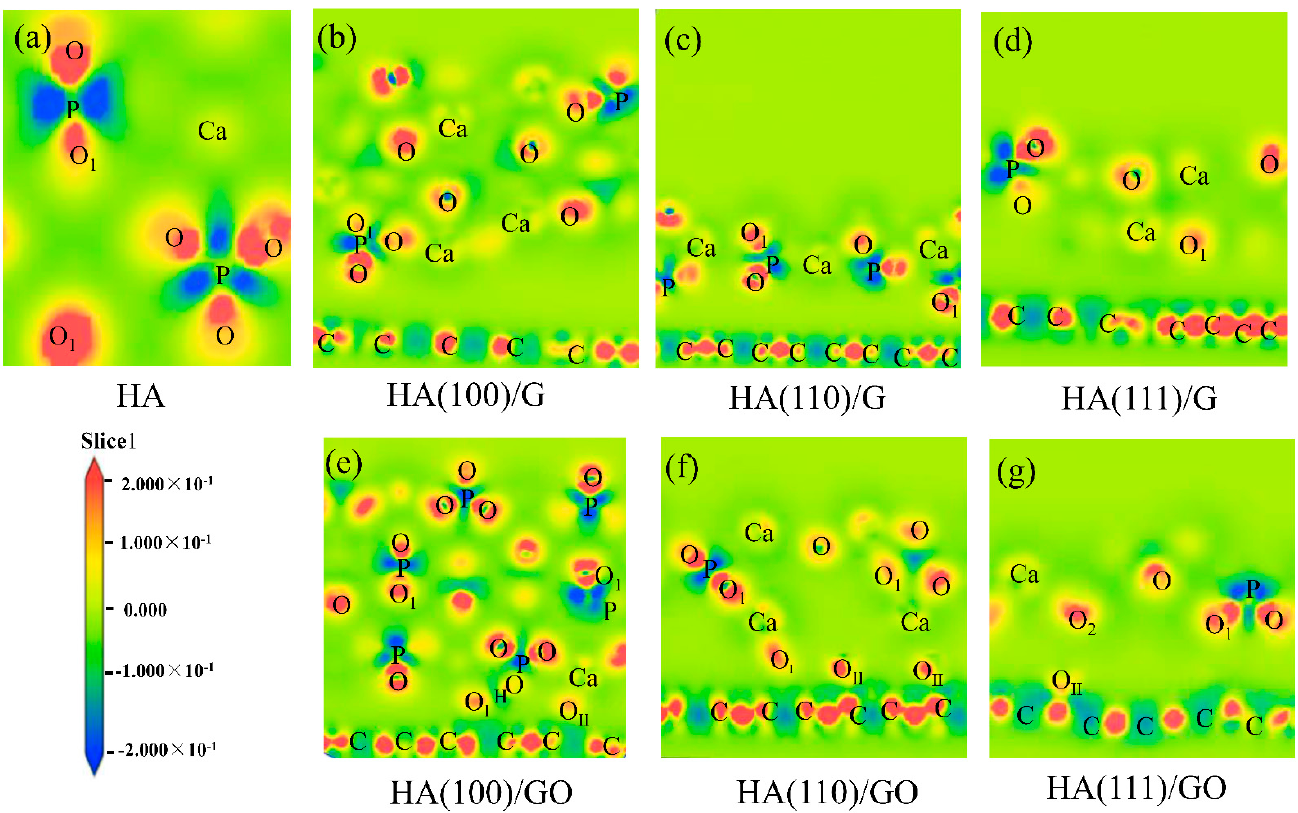
Figure 5. DCD maps of ( a ) pure HA and composite systems, ( b ) HA (100)/G, ( c ) HA (110)/G, ( d ) HA (111)/G, ( e ) HA (100)/GO, ( f ) HA (110)/GO and ( g ) HA (111)/GO.